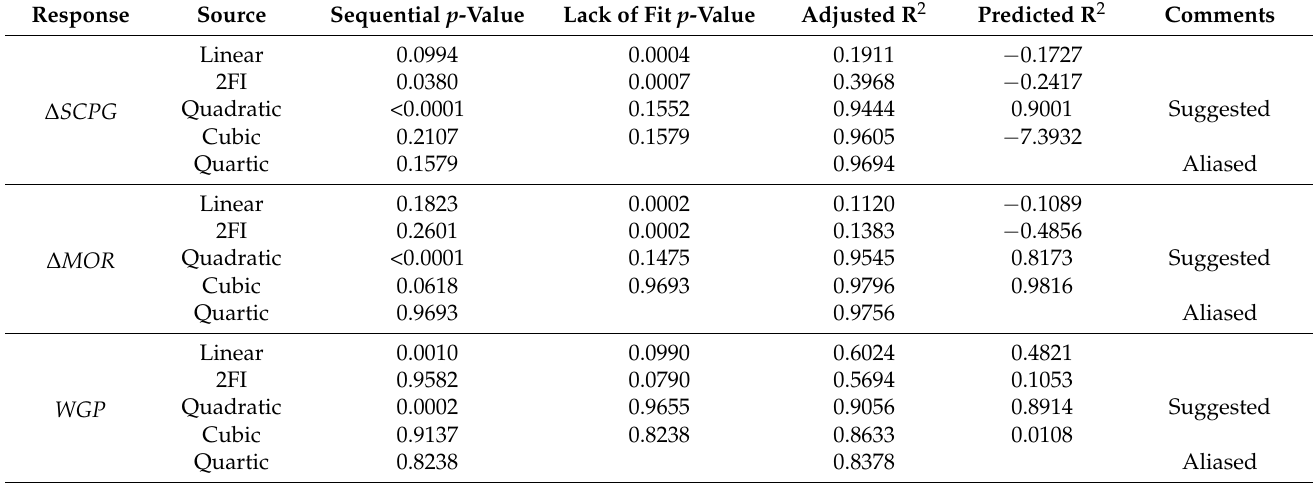
Table 3. Model summary